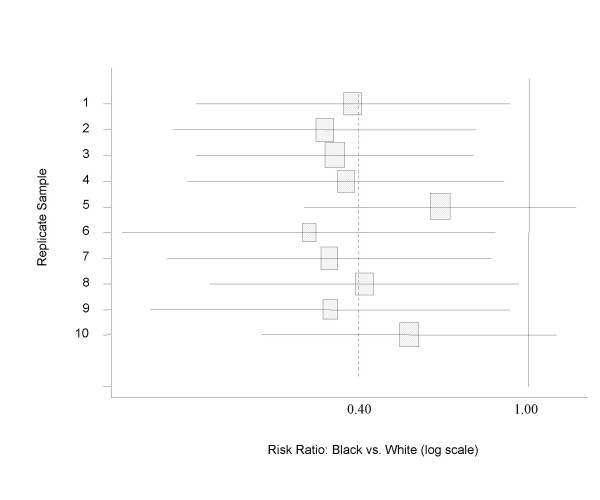
Results of regression analysis for race with the dependent variable mortality at 30-days. Forest plot demonstrating the results of the 10 individual conditional logistic regressions models for the dependent variable all-cause mortality at 30-days after adjusting for severity of illness using the PSI. The presented relative risk with 95% confidence intervals is for the independent variable race (dichotomized into black versus white).